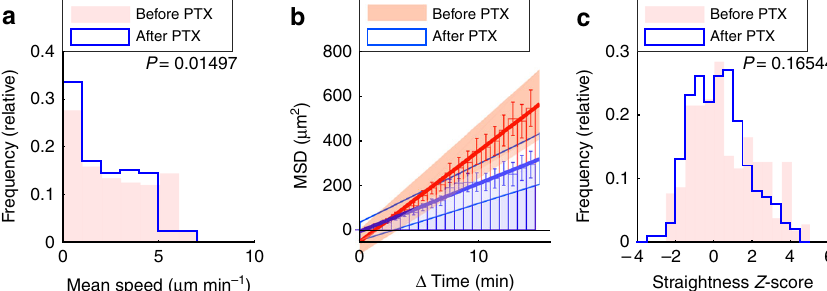
Fig. 6 Chemokines promote speed but not directionally persistent T cell migration. GFP + effector T cells were injected i.v. into LPS-treated mice. After two to fi ve days, lungs were explanted and imaged with two-photon microscopy. Identical regions were imaged before and after addition of pertussis toxin (PTX). Tracks with a duration of 15 min were analyzed ( n = 205 tracks both before and after treatment). a – c Mean speed ( a ), time vs. mean squared displacement (MSD) ( b ), and straightness Z -score ( c ) before and after treatment with inhibitor. ( b ) Bars show mean squared displacement. Also shown are standard errors ( error bars ), linear regression ( line ) and con fi dence intervals ( shaded areas ). Shown are pooled data from experiments with four distinct mice ( a , c ) or data from a single representative experiment ( b ). P -values were computed with the Mann – Whitney test